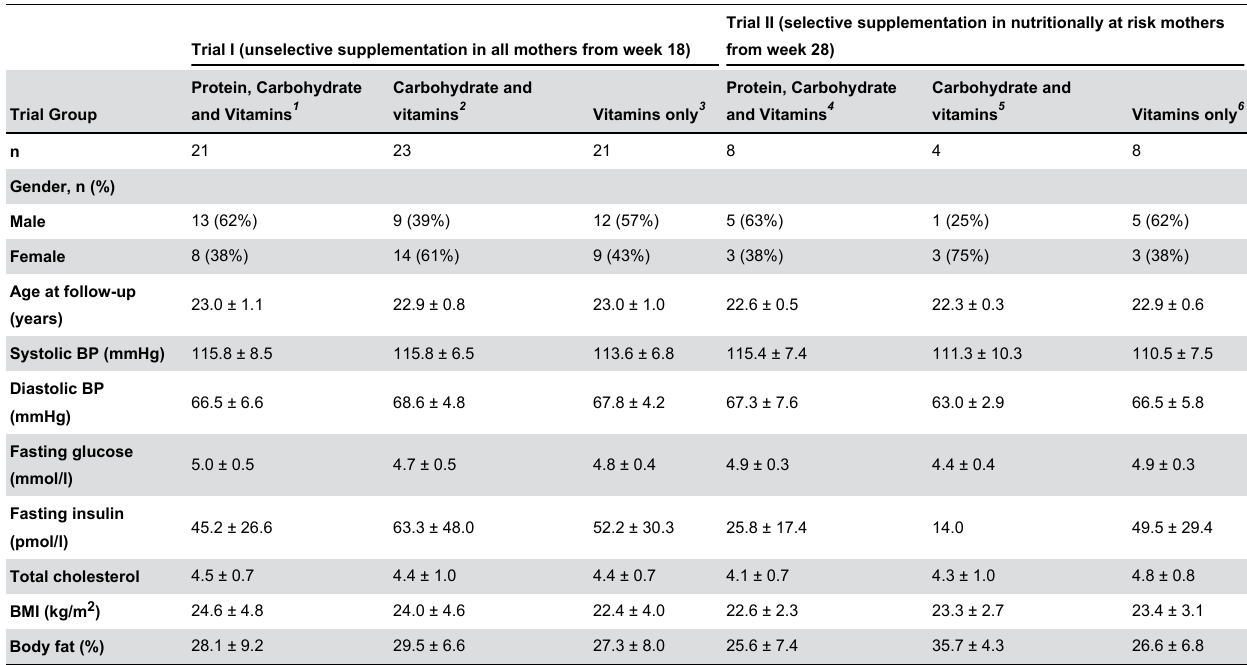
Table 1. Patient characteristics of adult children from the Sorrento studies of maternal nutritional supplementation (values are mean ± SD, unless stated